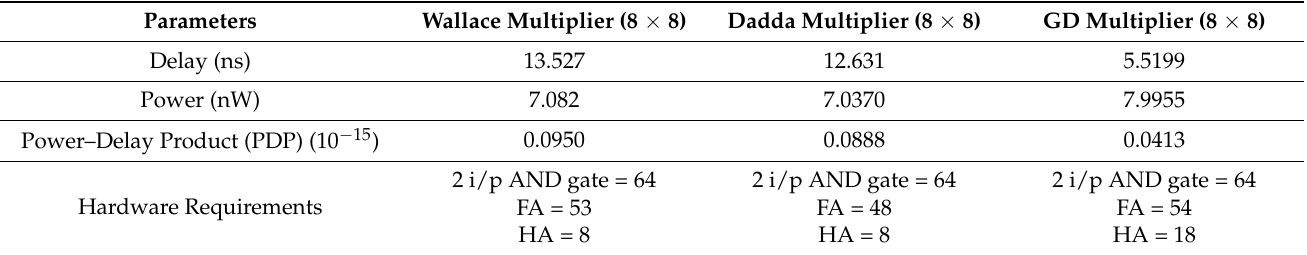
Table 3. Front-end performance analysis between GD and existing techniques with power and delay as